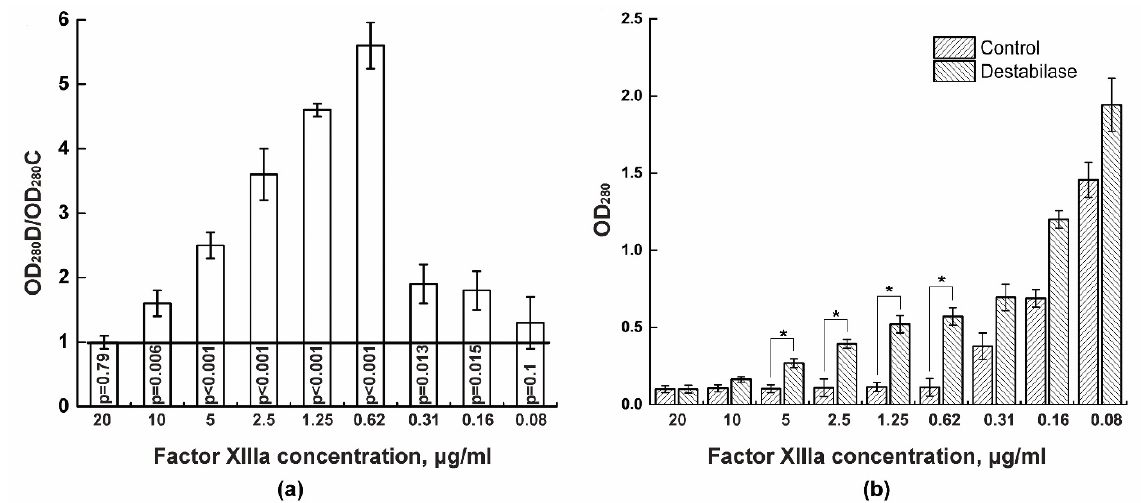
Figure 1. Determination of isopeptidase activity by the degree of dissolution of the fibrin clot in 5% monochloroacetic acid at various concentrations of factor XIII. Destabilase (10 μ g/mL) was added to the plasma with a known concentration of factor XIII; then, two-fold plasma dilutions were obtained, and a fibrinogen with additional components was mixed to form a fibrin clot. After incubation, the fibrin clot was dissolved in 5% monochloroacetic acid, and the absorbance of the supernatant was determined at 280 nm. The optical densities of the samples with destabilase (OD 280 D) and control samples (OD 280 C) were compared as a ratio. The black line shows the threshold of the difference from the control. The p -values were calculated and placed in columns ( a ). The dependence of the OD 280 of the dissolved fibrin clot degradation products on the factor XIIIa concentration in the presence or absence of destabilase was also compared. Differences were significant at p < 0.05 (*) ( b ).